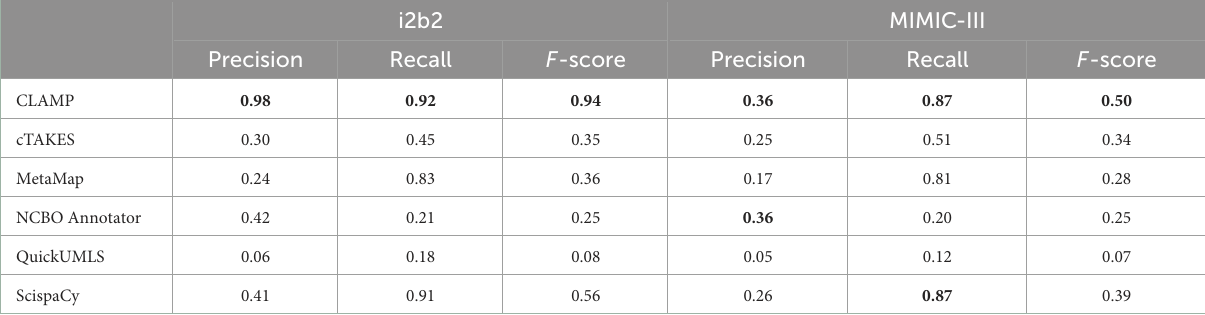
TABLE 4 Clinical concept recognition system performance on inexact match at extracting clinical concepts from the i2b2 and MIMIC-III datasets.